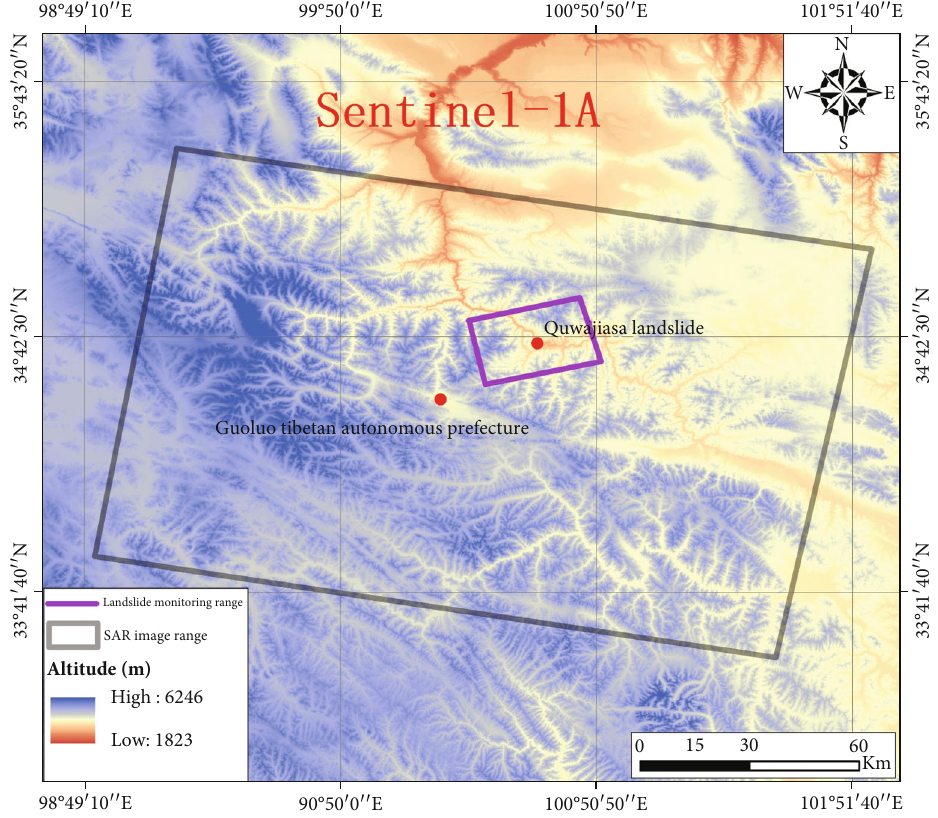
Figure 3: Data coverage and monitoring